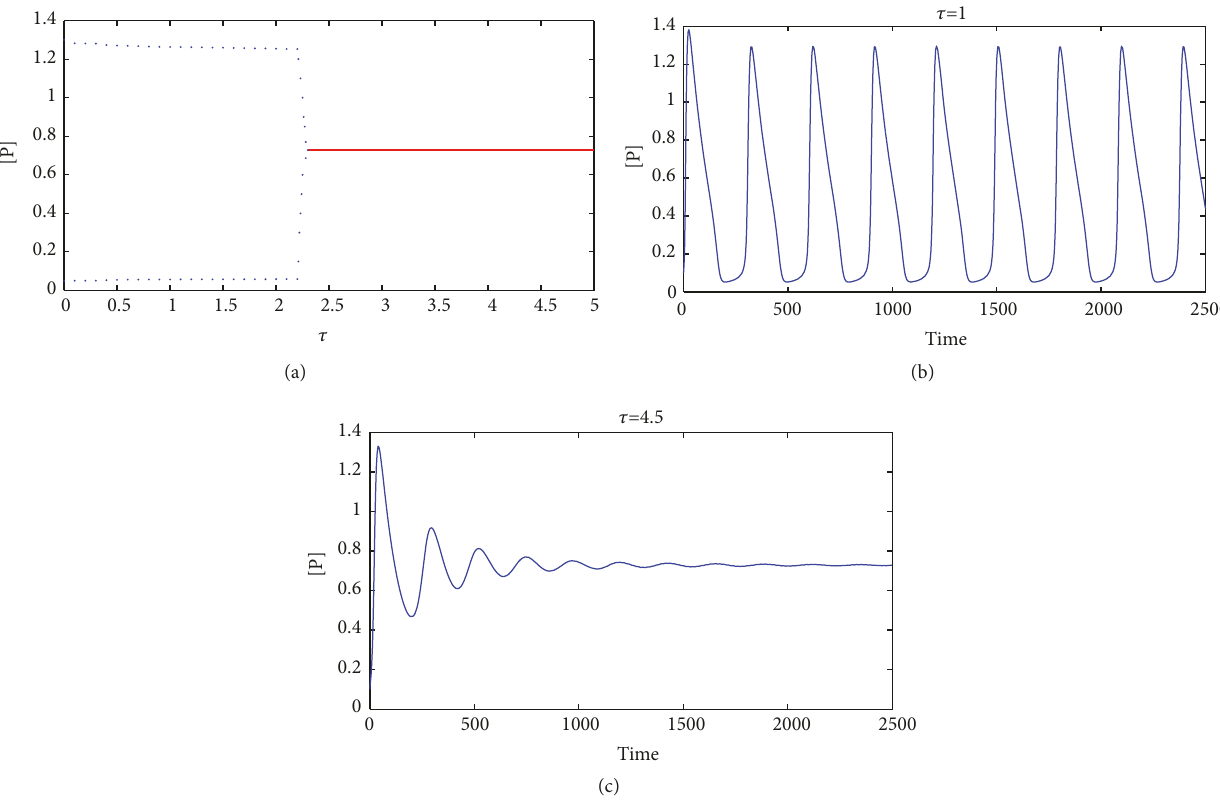
Figure 4: (a) Bifurcation diagram of [P] with time delay 𝜏 as the bifurcating parameter when fixing the negative feedback strength Γ 2 = 0.04 . The stable steady state is depicted by the red solid line, and the maxima and minima are depicted by the blue dots for the stable limit cycle. (b) and (c) are time courses diagram of [𝑃] for the parameter 𝜏 = 1 (b) and 4.5 (c), respectively. Initial conditions: 𝑃(0) = 0.1,𝑀(0) = 0.1